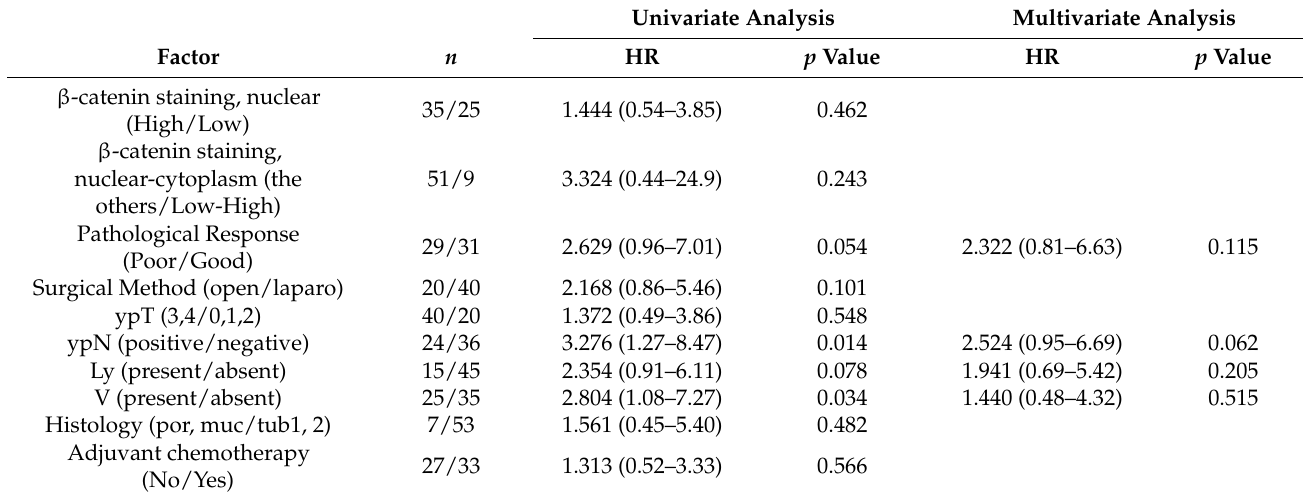
Table 5. Cont. Univariate Analysis Multivariate